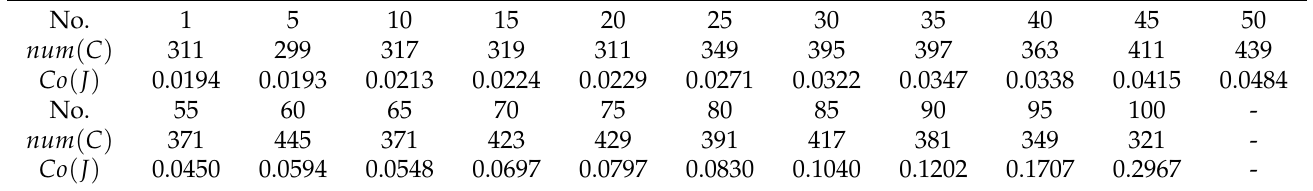
Table 3. num ( C ) and Co ( J ) in the interval EF